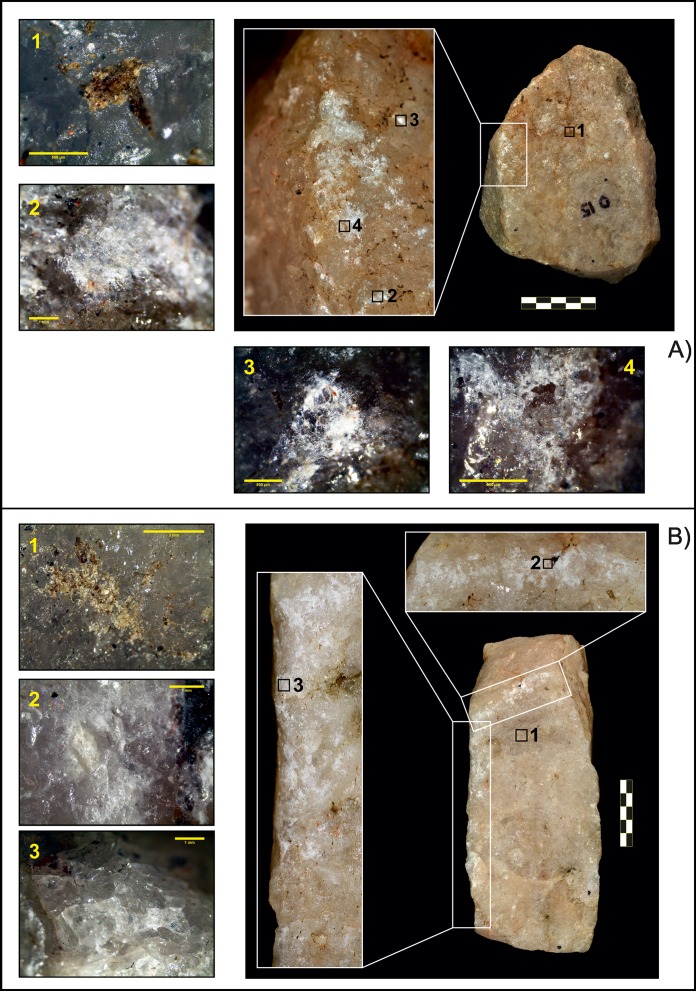
Quartzite passive elements.A) Piece O15 with crushing marks on the left lateral edge. 1. Residues identified before cleaning (80×, scale 500 μm); 2. Detail of crushing (20×, scale 1 mm); 3. Impact point (20×, scale 500 μm); 4. Pit associated with a crushed area (40×, scale 500 μm). B) Piece O48. 1. Detail of residues (16×, scale 3 mm); 2 and 3. Crushing (25× and 20×, both scales 1 mm).